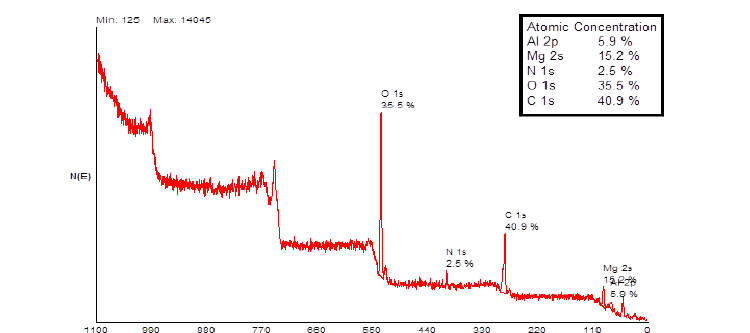
XPS analysis of oxide layer